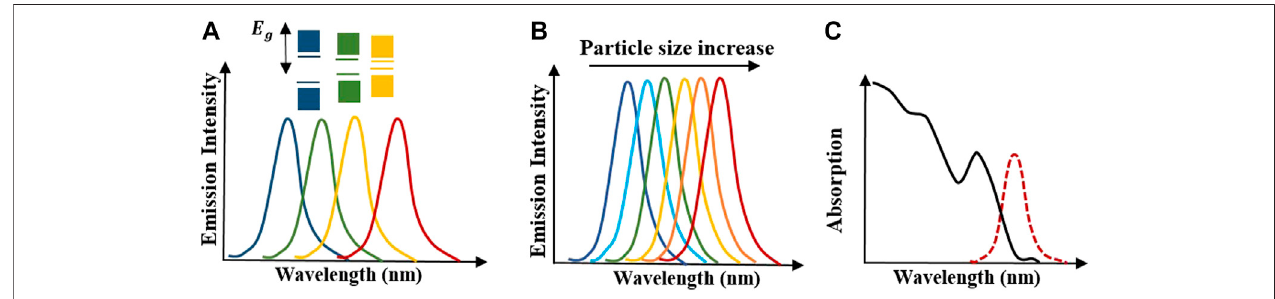
FIGURE 3 | Quantum dot optical properties (A , B) Bandgap energy dependency on particle size. (C) Their emission multispectral ability